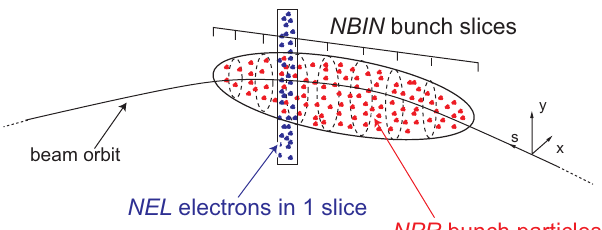
FIG. 1. (Color) Schematic of the physical model for the cloud- beam interaction in the HEADTAIL code.